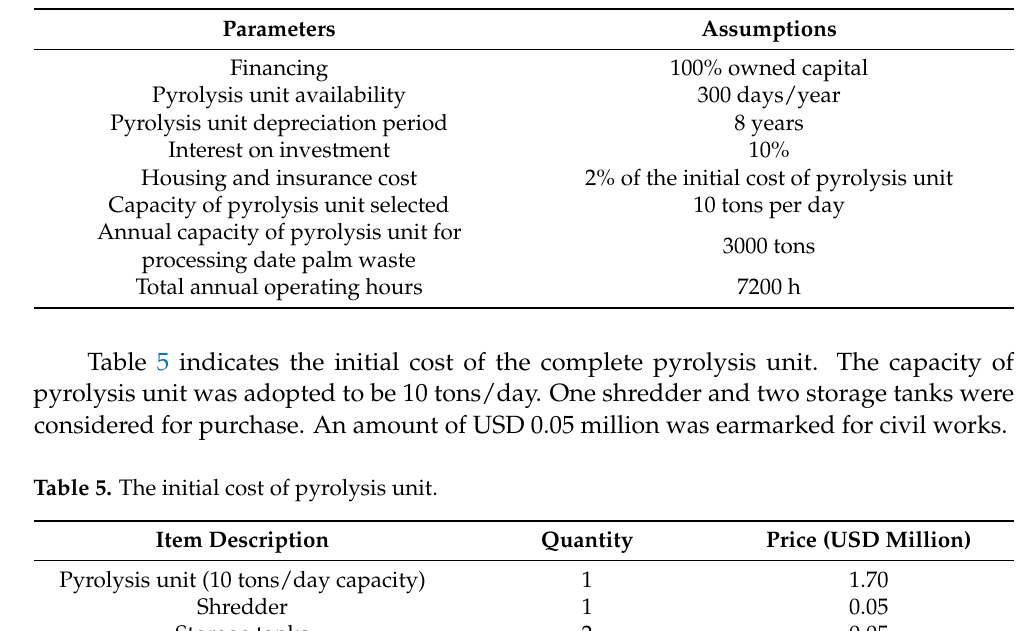
Table 4. Assumption for pyrolysis unit.